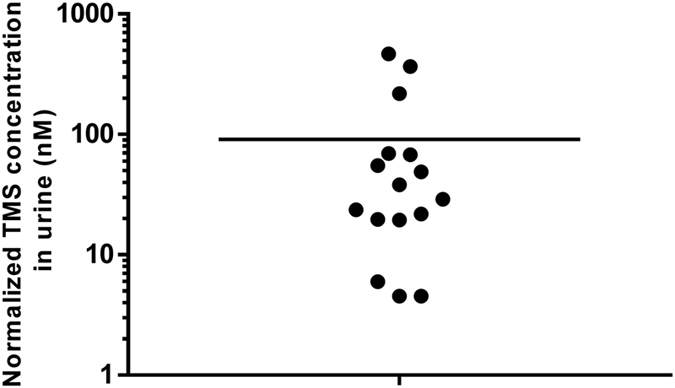
Trimethylsulfonium urinary levels in a group of 16 healthy volunteers.The line represents the average concentration. The concentrations were normalized according to specific gravity based on the equation: Cnormalized = Cmeasured (SGaverage − 1)/(SGsample − 1)17.